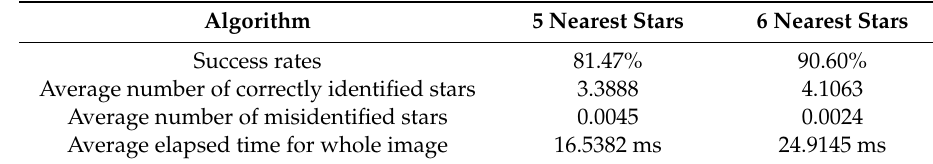
Table 9. Case 2: Parameter study of proposed methods at 150 arc-seconds position